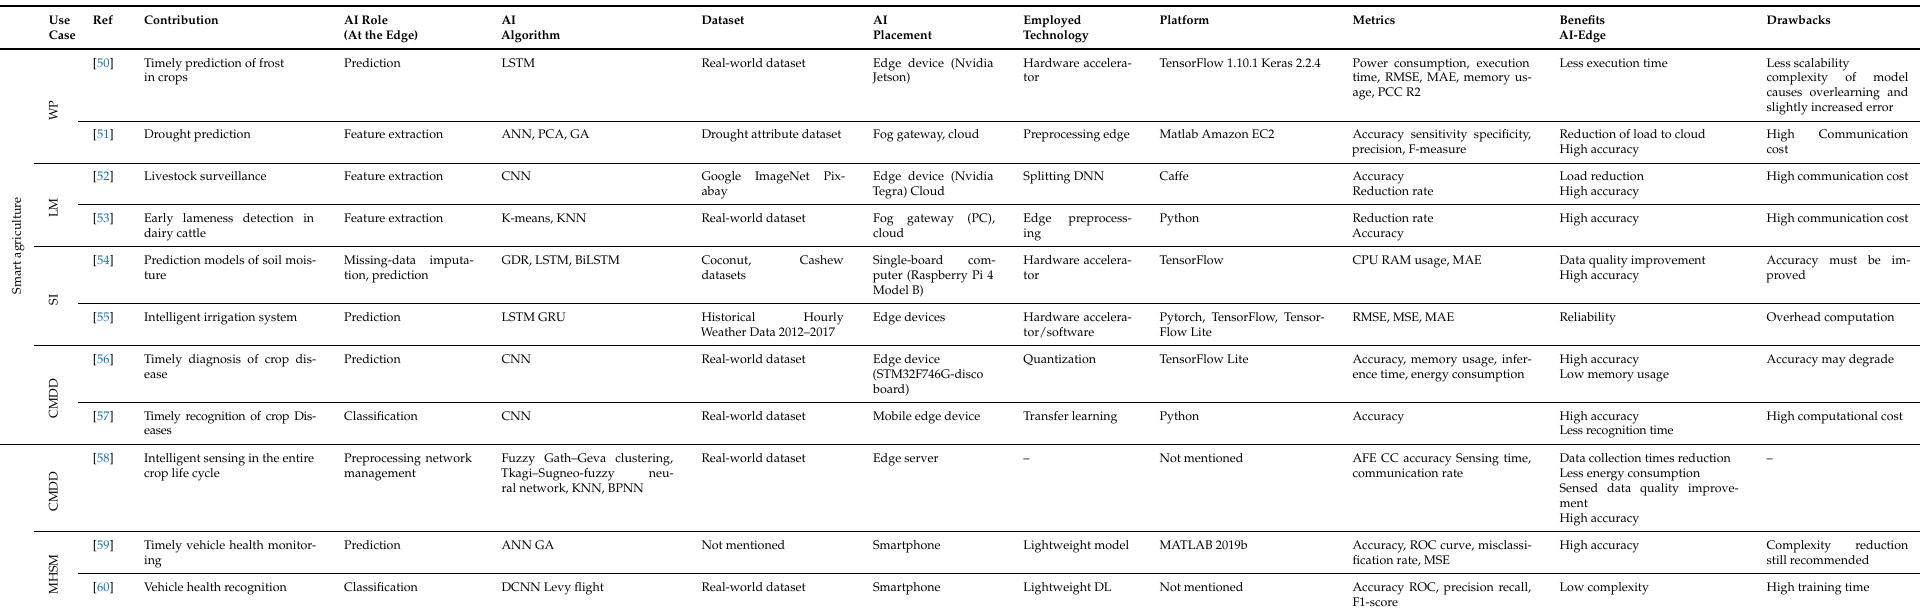
Table 5. Qualitative comparison of smart agriculture related